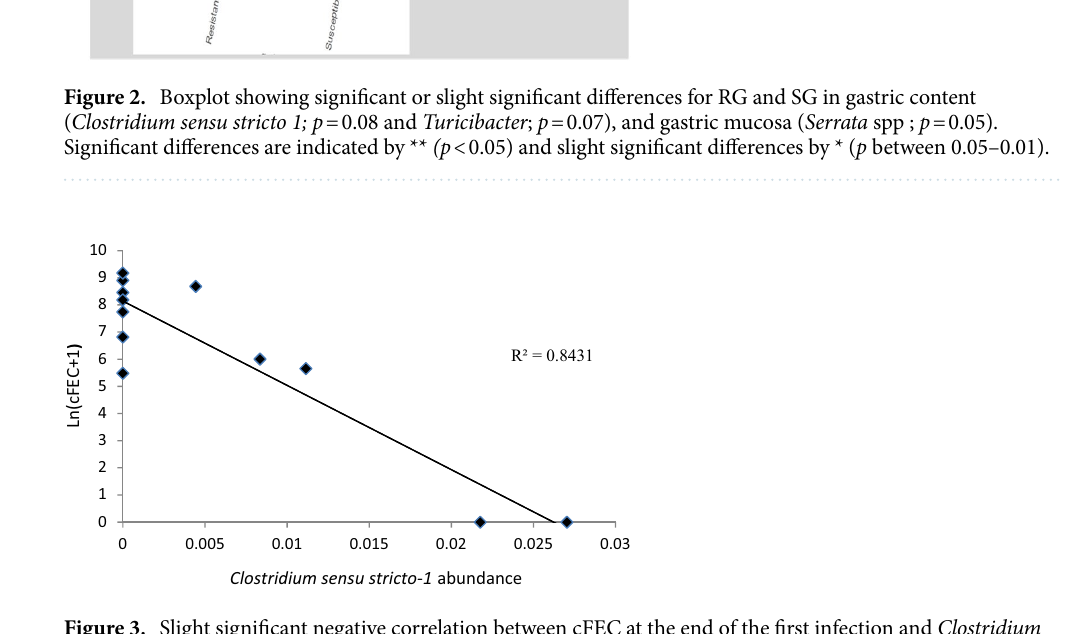
Figure 3. Slight significant negative correlation between cFEC at the end of the first infection and Clostridium sensu stricto 1 abundance. Rho =− 0.537 and p =